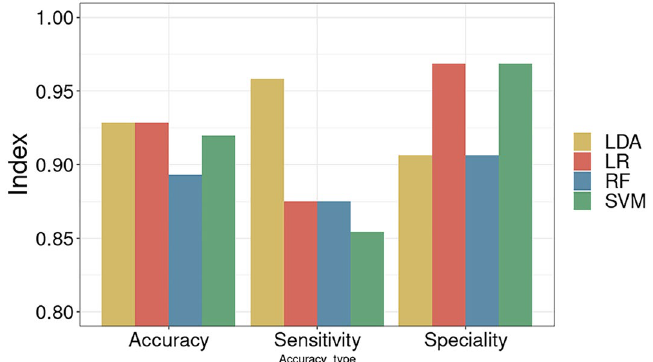
Figure 4. LDA and LR perform better on CMV data. Figure depicts the optimal performance of each algorithm corresponding to the optimal threshold value to obtain the accuracy, sensitivity and specificity of each